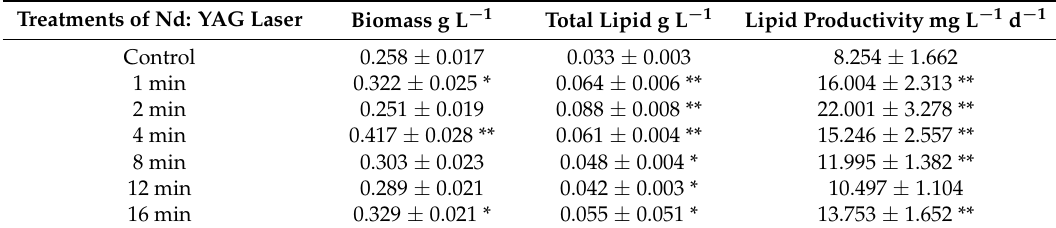
Table 1. Biomass concentrations, total lipid content and lipid productivity of C. pacifica treated by Nd: YAG laser gradients at the end of cultiviation.